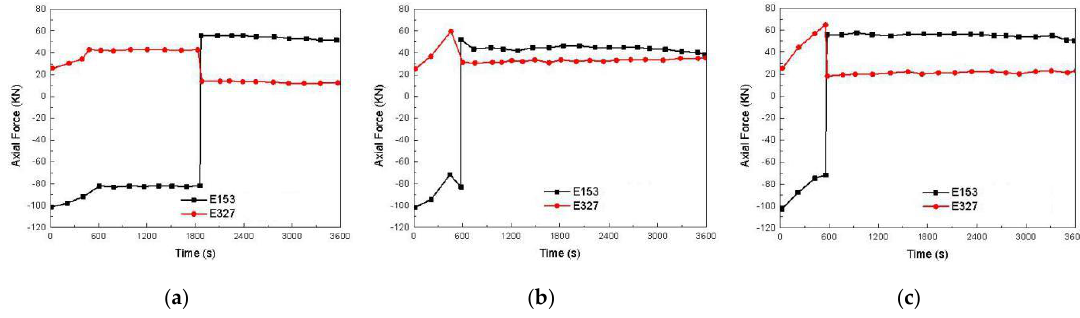
Figure 22. Time-history curves of axial force of key members in different fire conditions. ( a ) Fire location I (1863s); ( b ) fire location II (582s); ( c ) fire location III (567s).